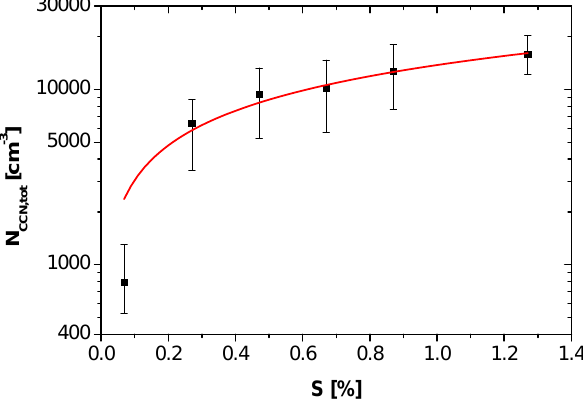
Fig. 8. CCN number concentrations ( N CCN , S ) averaged over the entire campaign and plotted against water vapor supersaturation ( S ). The data points are median values, and error bars extend to lower and upper quartiles. The red line is a classical power law fit of the function N CCN , S = N CCN , 1 · (S/( 1% )) k with the best fit parameters N CCN , 1 =13699cm − 3 and k =0.65 ( R 2 =0.97, n